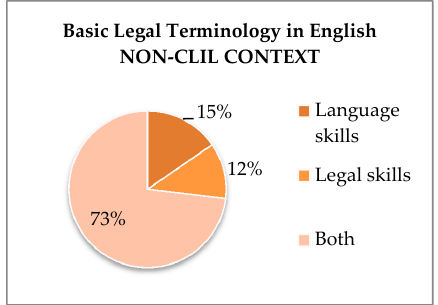
Figure 2. Law students’ expectations towards the skills to develop in their English for Specific Purposes (ESP) course.